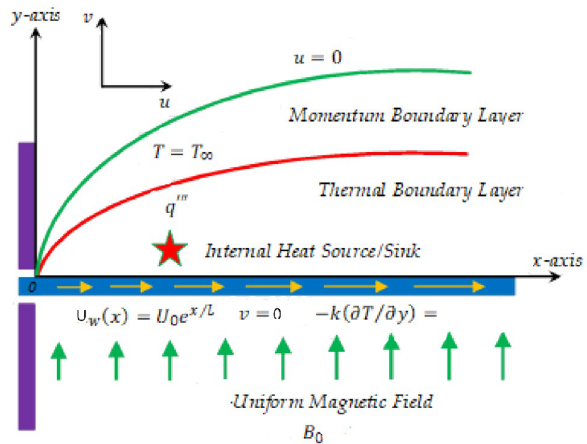
Figure 1. Geometry of the